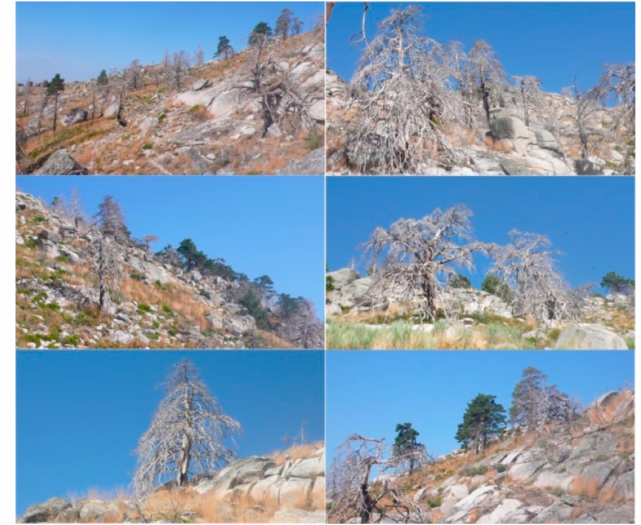
Figure 2. Views of burnt Scots pine trees in a stand located in the study area affected by a fire in 2009 (stand situated near Puerto del Pico site, see Figure